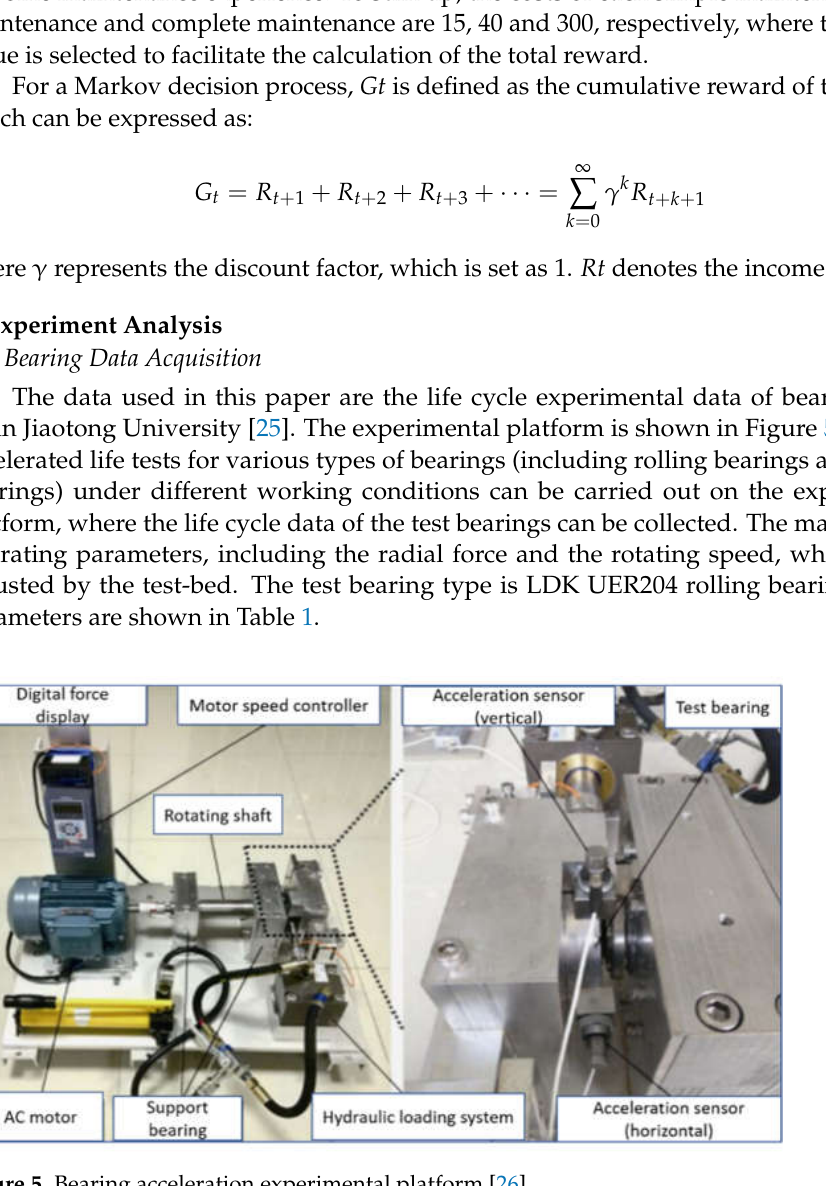
Figure 5. Bearing acceleration experimental platform [26]. Table 1. LDK UER204 Bearing parameters.